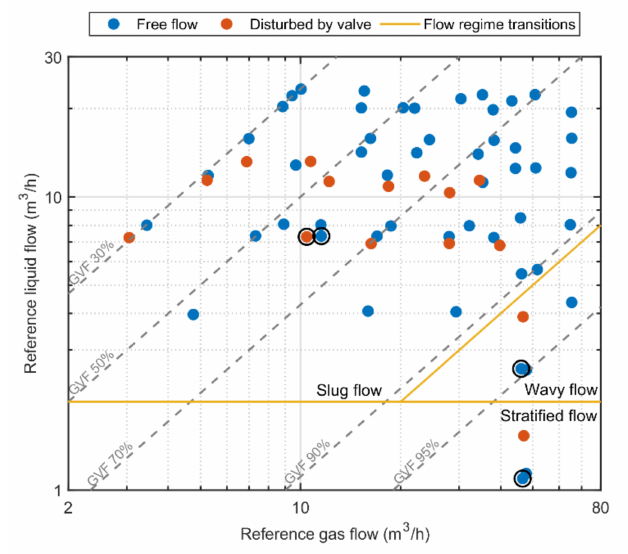
Figure 4. The measured single phase reference flow rates for all two-phase air-water flow experiments performed in this study indicated as dots. The dashed lines indicate the gas volume fraction (GVF) of the multiphase flows. Flow experiments have been performed for free flow and for flow disturbed by a downstream valve. Approximate flow regime transition boundaries were derived from visual inspection and are indicated by the solid lines. Four experiments that are discussed in more detail in this article are highlighted by a black